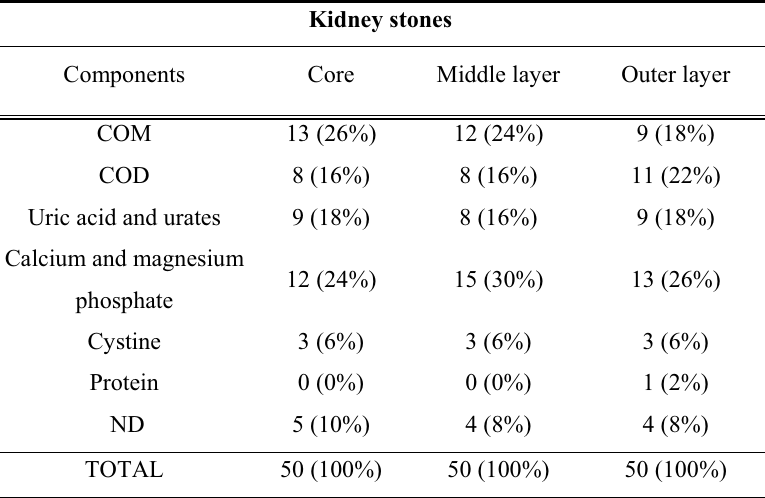
TABLE 2 - Findings from the morphological analysis of 50 kidney stones analyzed according to the protocol of Daudon et al.